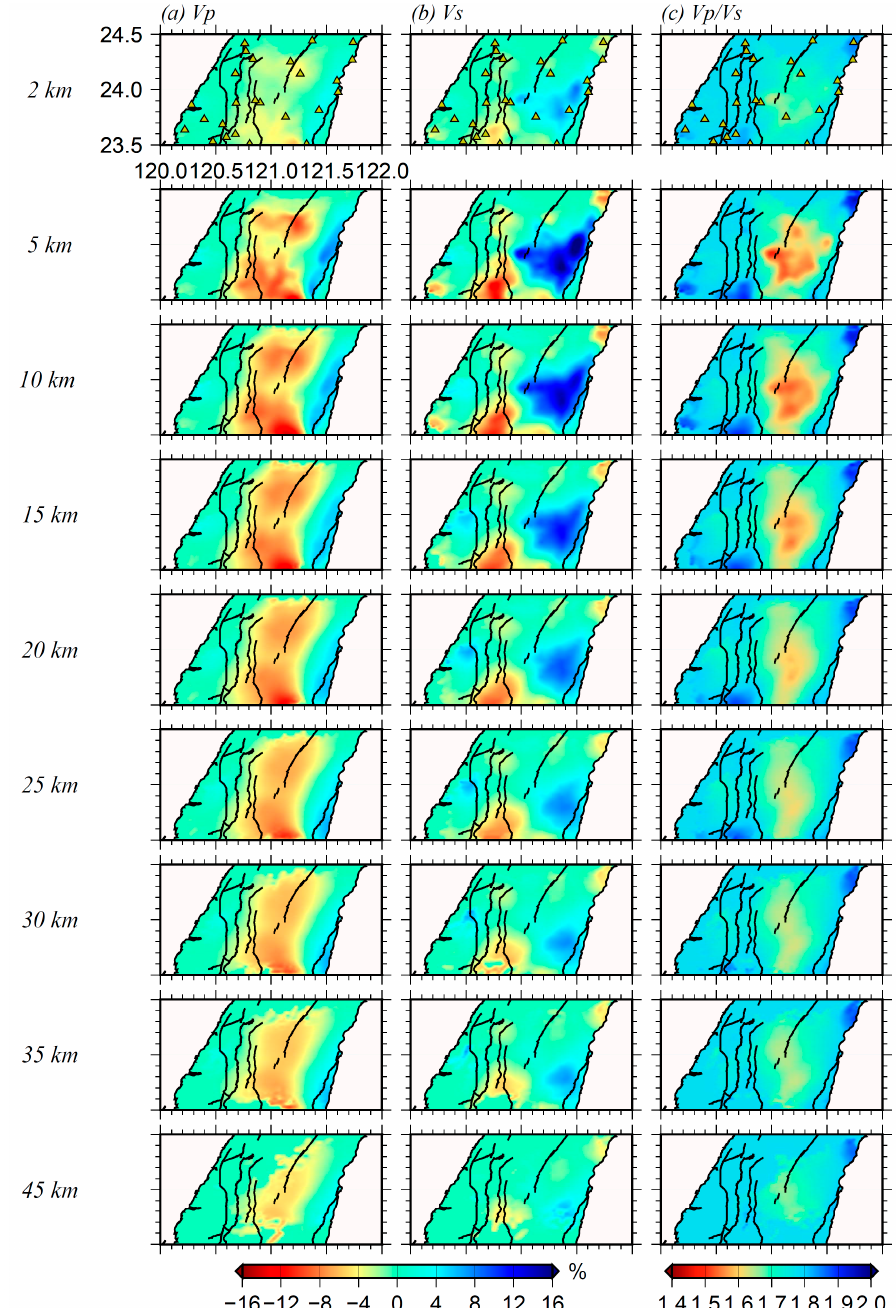
Figure A1. This study is divided into three periods to explore the Vp, Vs, and Vp/Vs in the study area. Yellow triangle represents the station. The results of Figure A1 represent the first period. ( a ) Vp at different depths. ( b ) Vs at different depths. ( c ) Vp/Vs at different depths.